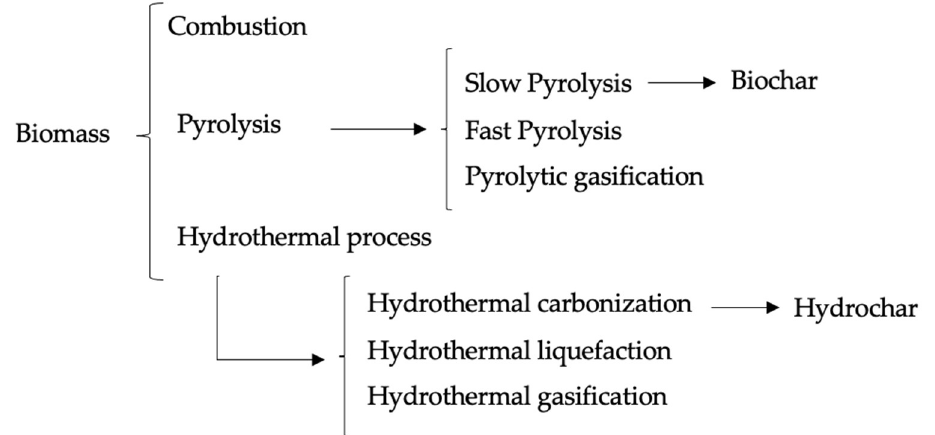
Figure 1. Conversion pathways from biomass to bio/hydrochar.